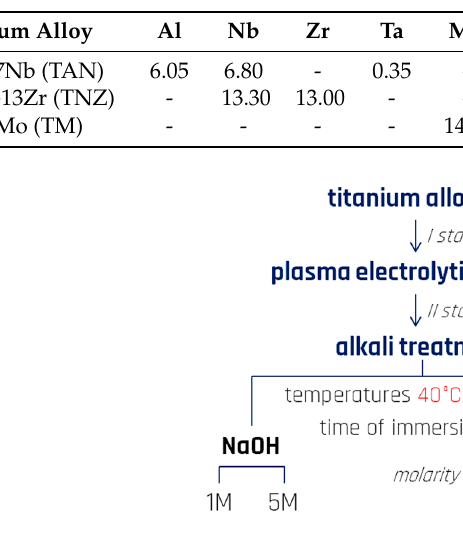
Table 1. The chemical composition of the titanium alloys (wt %).